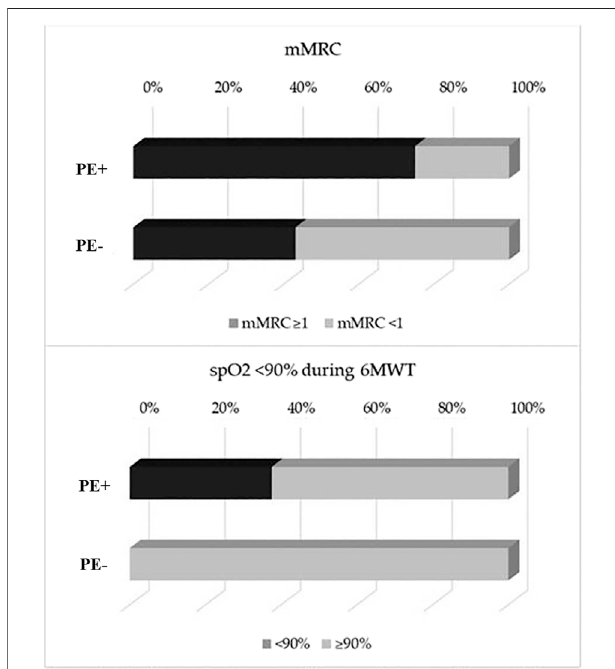
FIGURE 2 | Bar diagram showing differences between PE+ AND PE − in termsofmMRC ≥ 1(75vs54.3%, p < 0.001)(upperpanel)andforSpO 2 < 90% during 6-minute walk test (6MWT) (37.5 vs 0%, p < 0.001) (lower panel). PE, Pulmonary Embolism; mMRC, modi fi ed Medical Research Council Dyspnea scale; 6MWT, 6-minute walk